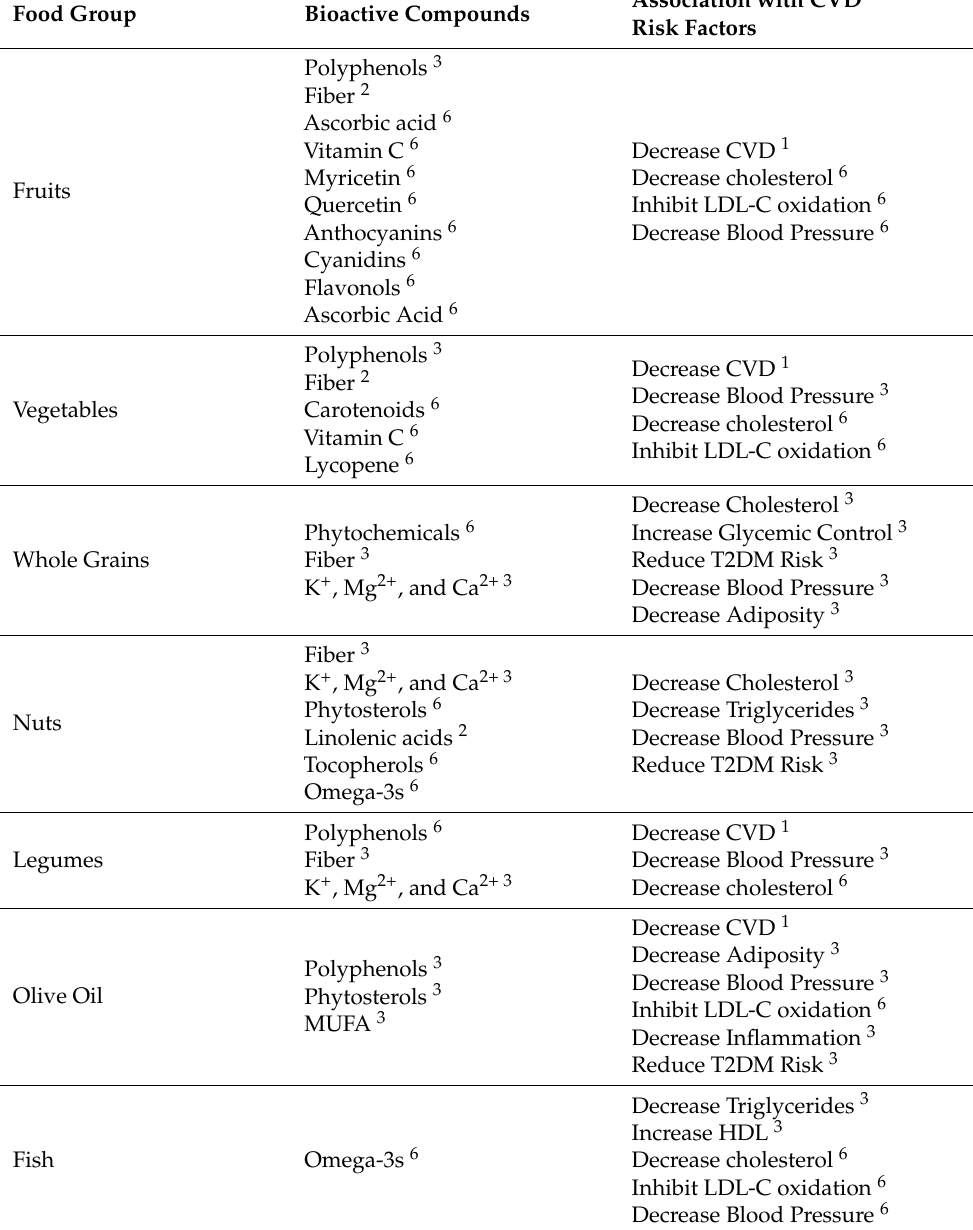
Table 1. Individual Components of the Mediterranean Diet and their Constituent Bioactive Com- pounds and Associations with Cardiovascular Disease (CVD) Risk